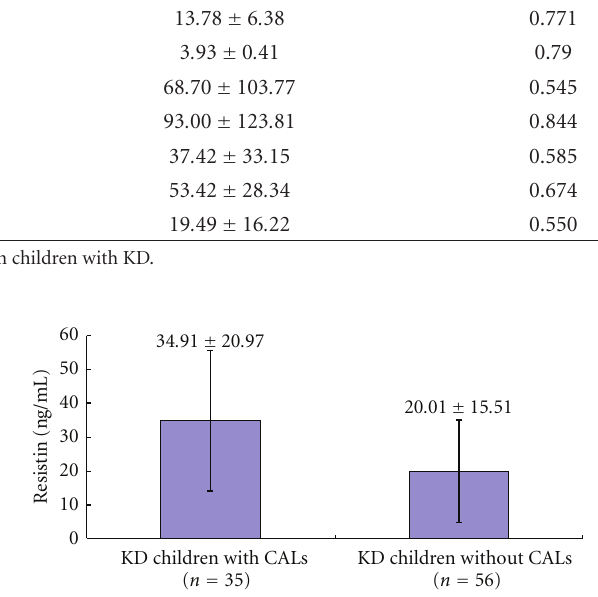
Figure 1: Serum resistin levels in children with the Kawasaki disease (KD) and control subjects. Figure 2: Serum resistin levels in the Kawasaki disease (KD) children with and without